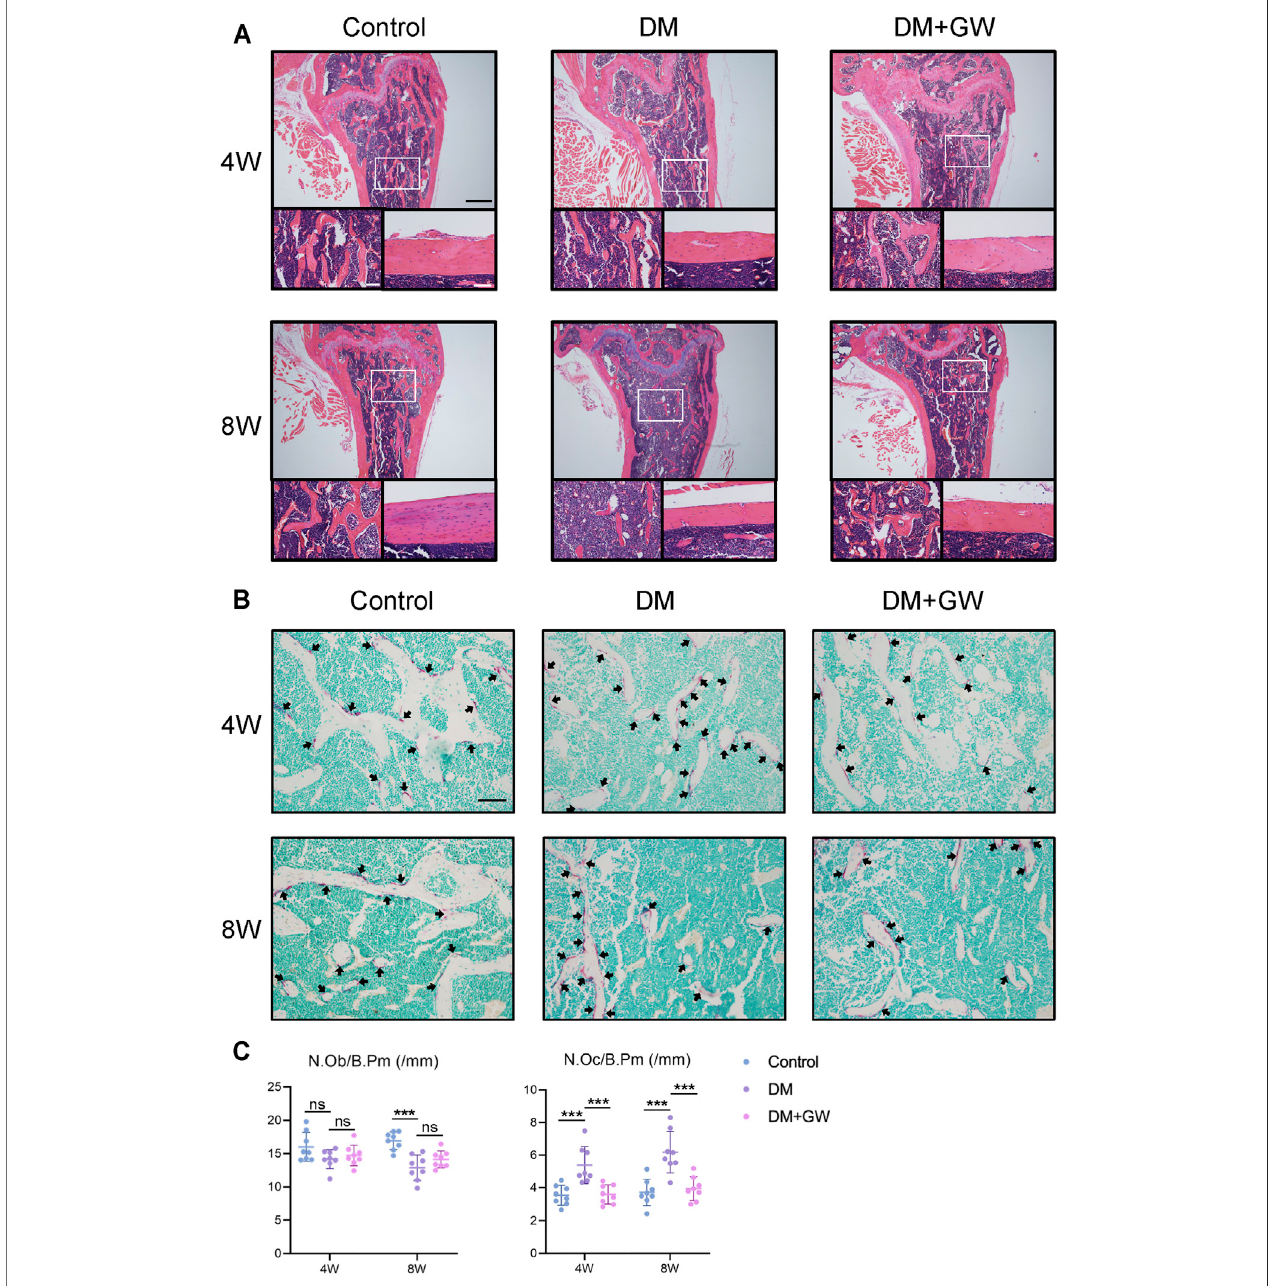
FIGURE 2 | PPAR β / δ agonist reduces the bone loss and osteoclast activation in diabetic mice. (A) Representative images of H&E staining of distal femoral tissue sections. Scale bar (cid:2) 500 µm (top), scale bar (cid:2) 100 µm (bottom). (B) Representative images of TRAP staining of distal femoral tissue sections. TRAP positive cells were indicatedbyarrows.Scalebar (cid:2) 100 µm. (C) Statisticsforthenumberofosteoblastsandosteoclasts.Datawereexpressedasmean ± SD.The p valueswerecalculated by one-way ANOVA. (ns, not statistically signi fi cant, *** p < 0.001). N. Ob/B.Pm (cid:2) osteoblast number/bone perimeter, N. Oc/B.Pm (cid:2) osteoclast number/bone